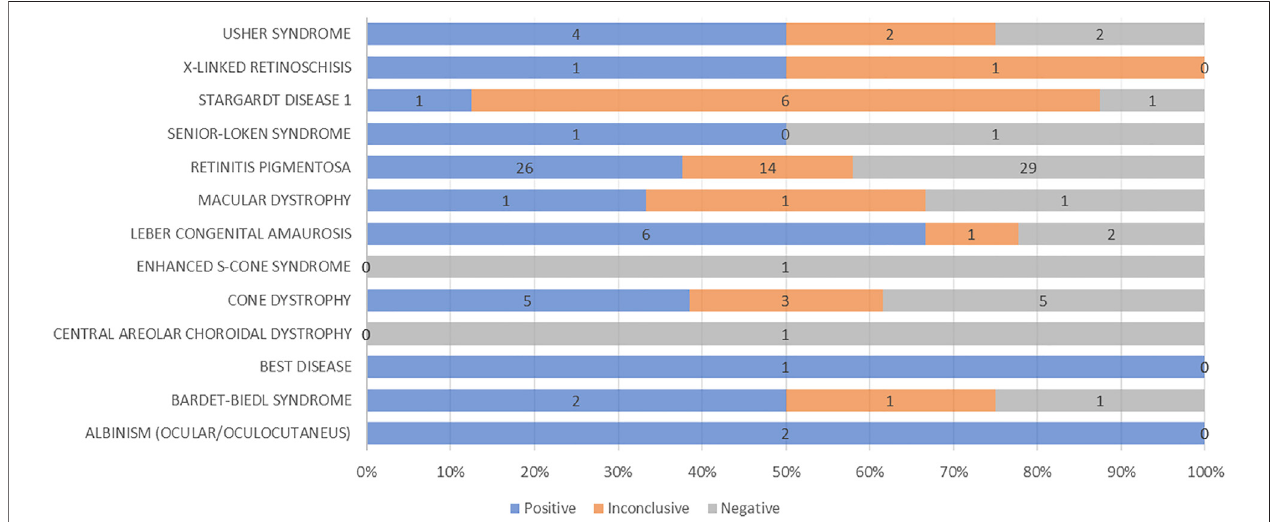
FIGURE 6 | Graphical representation of diagnostic yield for each phenotype analyzed by genetic